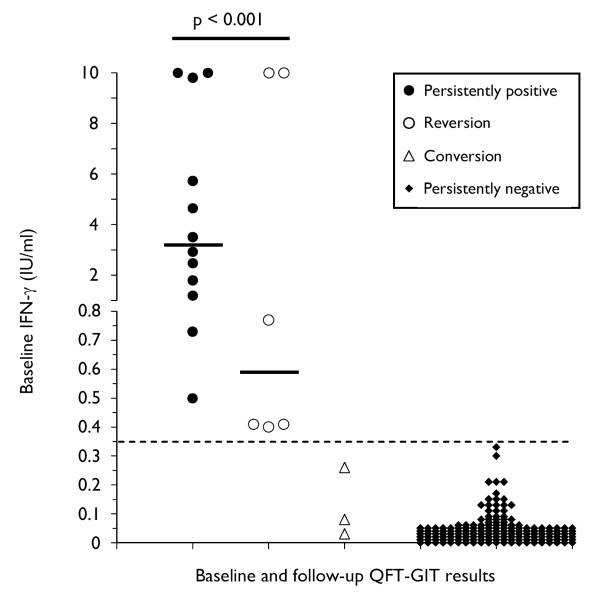
Comparison of the baseline level of IFN-γ responses and consistency of QFT-GIT results. The short bar represents the median level of IFN-γ responses in subjects with positive baseline results (3.22 vs. 0.59 IU/ml, p < 0.001). The baseline IFN-γ responses of the subjects with conversions and consistently negative results are plotted for comparison. The responses of four subjects with indeterminate results are not shown. The dashed line represents the diagnostic cut-off ≥ 0.35 IU/ml. IFN-γ responses ≥ 10 IU/ml are shown as 10 IU/ml, IFN-γ responses < 0.00 IU/ml are shown as 0.00 IU/ml. IFN = interferon; QFT-GIT = QuantiFERON®-TB Gold In-Tube.